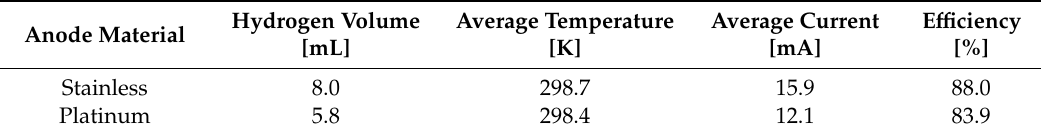
Table 3. Experimental result according to anode material.